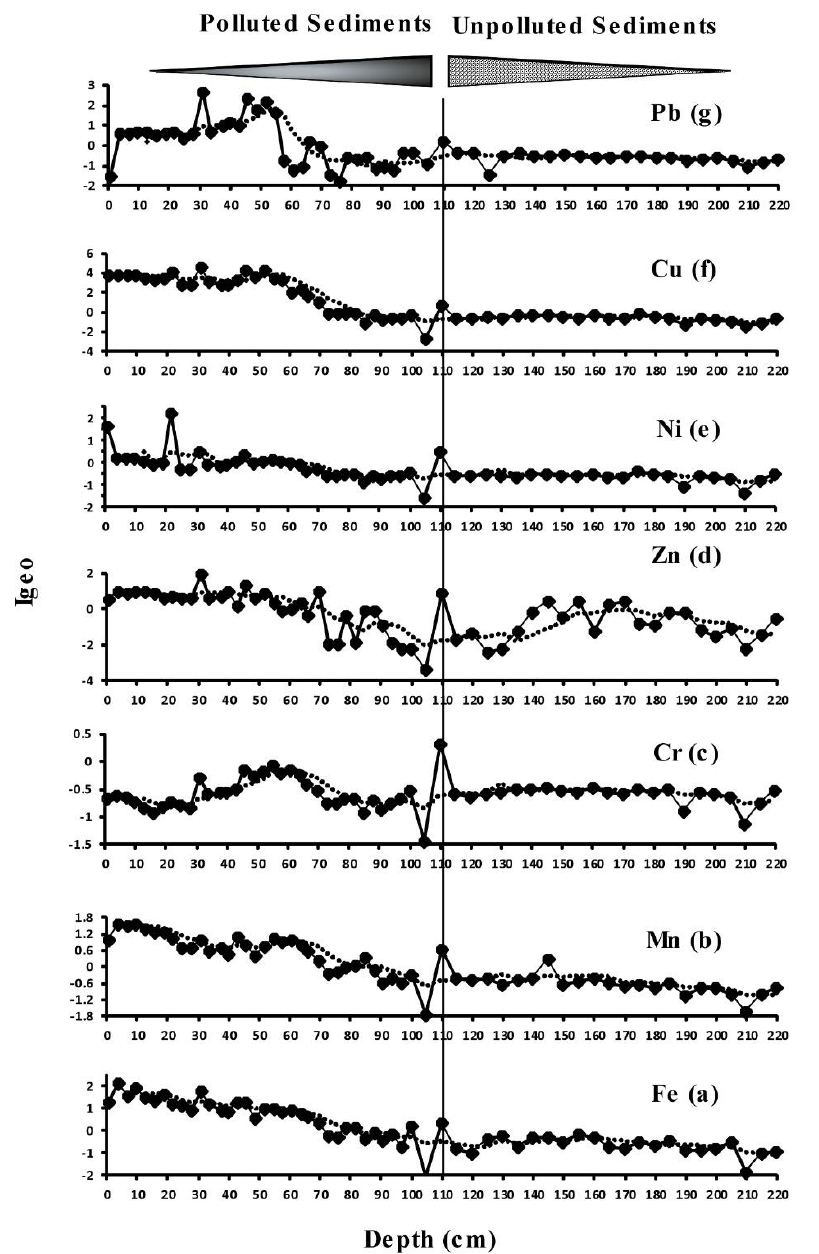
Figure 5. ( a – g ) Profiles of geo-accumulation index (I geo ) for metals in the Salam1 core from Al-Salam Lagoon, along the Jeddah coast, Saudi Arabia. (Trend line of 5 Average is shown by dots).